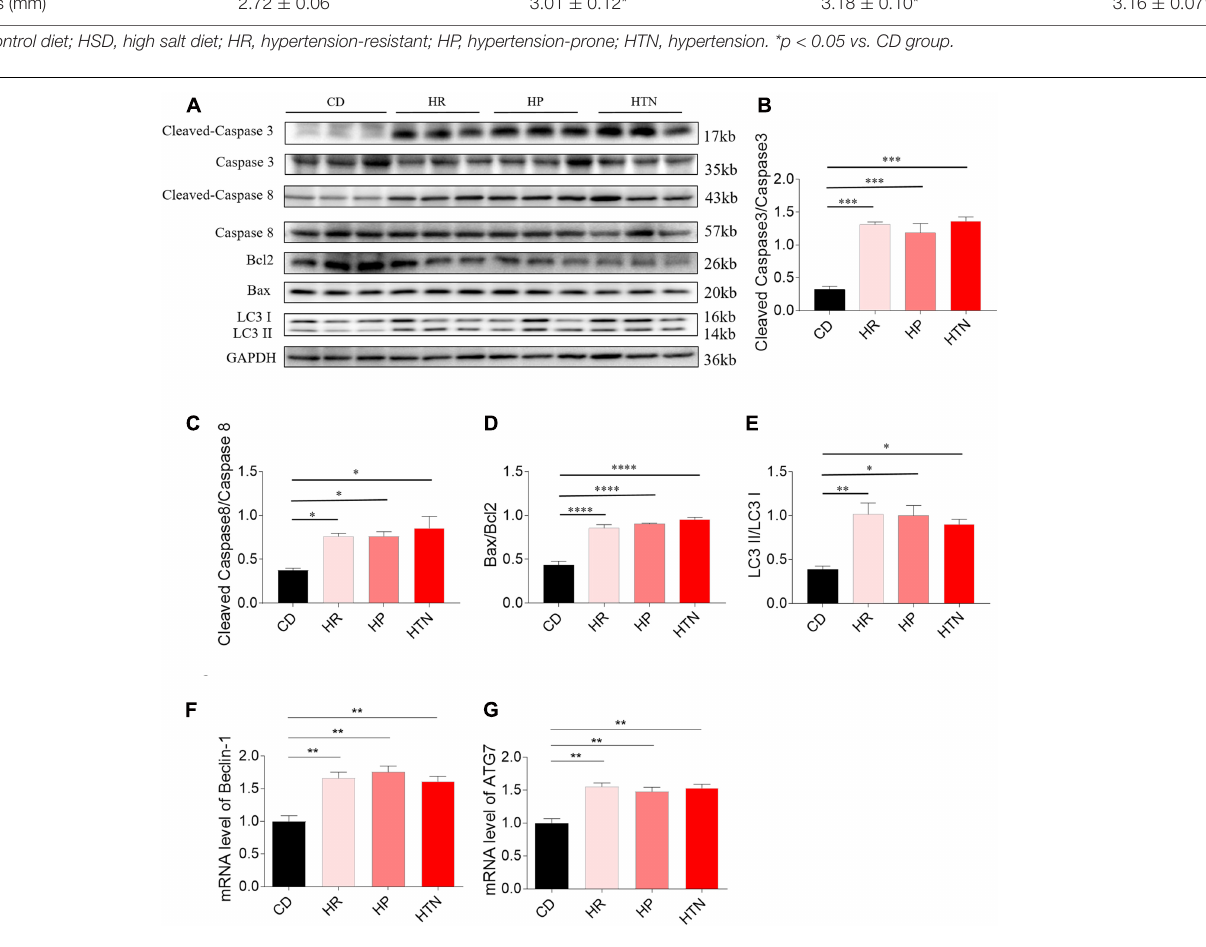
H9C2 cells. Middle (50 mM) and high (100 mM) doses of NaCl reduced p-eNOS level in H9C2 cells ( Figure 4A ). The level of eNOS was elevated, but p-eNOS level was reduced in the heart of HSD rats with HR compared with the control rats ( Figure 4B ). Middle (50 mM) and high (100 mM) doses of NaCl increased the mRNA level of iNOS in H9C2 cells, while low dose of NaCl